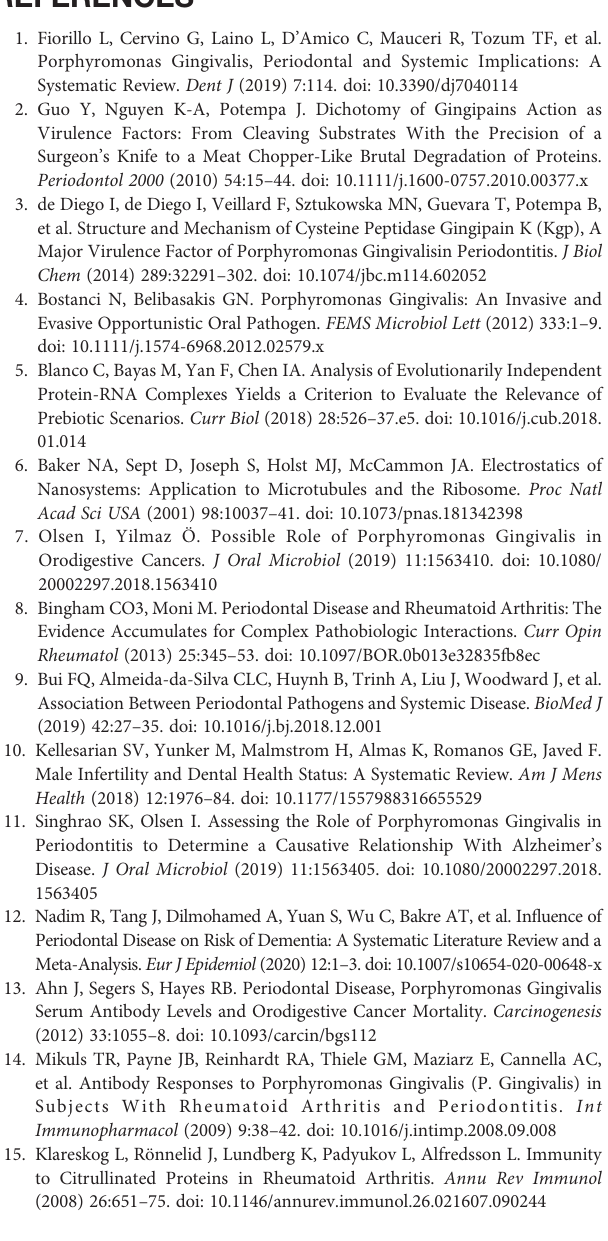
Supplementary Table 9 | Nervous system cell-type enrichment results for the SRP-dependent cotranslational protein targeting to membrane